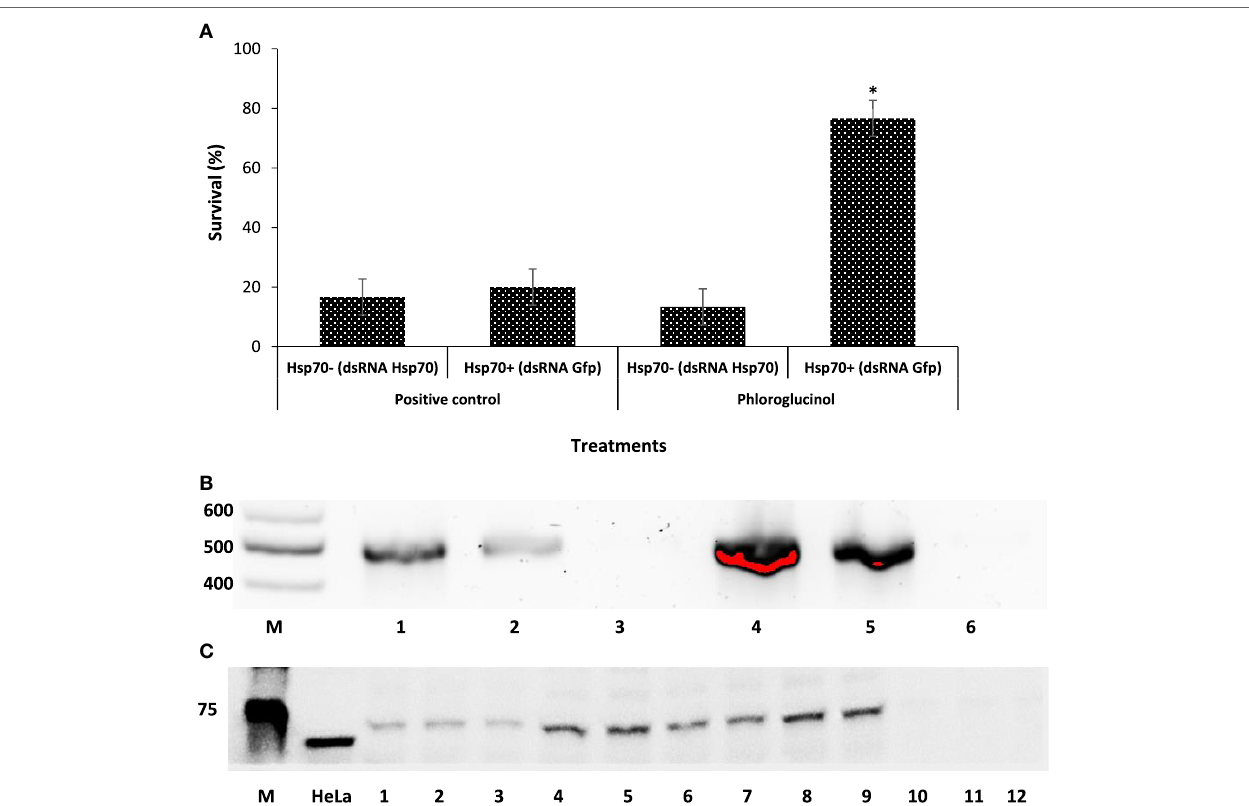
FigUre 3 | Knockdown of heat shock protein 70 (Hsp70) by RNA interference (RNAi) reduces the tolerance of brine shrimp larvae to Vibrio parahaemolyticus infection. (a) Hsp70 protects brine shrimp larvae against V. parahaemolyticus MO904 . Brine shrimp larvae obtained from females injected with either gfp ( + Hsp70) or hsp70 dsRNA ( − Hsp70) were pretreated with phloroglucinol (30 µM) for 2 h, rinsed to wash away the compound, and then allowed to recover for 2 h. The larvae were subsequently challenged with V. parahaemolyticus at 10 7 cells/ml. Phloroglucinol non-pretreated larvae with and without hsp70 that were challenged with V. parahaemolyticus served as positive control. Error bars represent the standard error of six replicates; asterisks represent significant difference between the control and the treatment, * P < 0.001. (b) Knockdown of hsp70 mRNA in brine shrimp larvae. Equal amounts of RNA from brine shrimp larvae were amplified by RT-PCR and the products were resolved by electrophoresis in agarose gels. M—100 bp DNA ladder, Lane 1—wild-type brine shrimp larvae, Lane 2—brine shrimp larvae injected with dsRNA gfp , Lane 3—brine shrimp larvae injected with dsRNA hsp70 , Lane 4—wild-type brine shrimp larvae pretreated with phloroglucinol, Lane 5—brine shrimp larvae injected with dsRNA gfp and pretreated with phloroglucinol, Lane 6—brine shrimp larvae injected with dsRNA hsp70 and pretreated with phloroglucinol. (c) Knockdown of Hsp70 protein in brine shrimp larvae. The brine shrimp larvae from females injected with dsRNA for either gfp or hsp70 were resolved by electrophoresis in SDS polyacrylamide gels, blotted to nitrocellulose, and probed with Hsp70 antibody (3A3). The secondary antibody was HRP- conjugated donkey anti-mouse IgG. M—Protein ladder in kilodaltons, Lanes 1–3—wild-type brine shrimp larvae, Lanes 4–6—wild-type brine shrimp larvae pretreated with phloroglucinol, Lanes 7–9—brine shrimp larvae injected with dsRNA gfp and pretreated with phloroglucinol, Lanes 10–12—brine shrimp larvae injected with dsRNA hsp70 and pretreated with